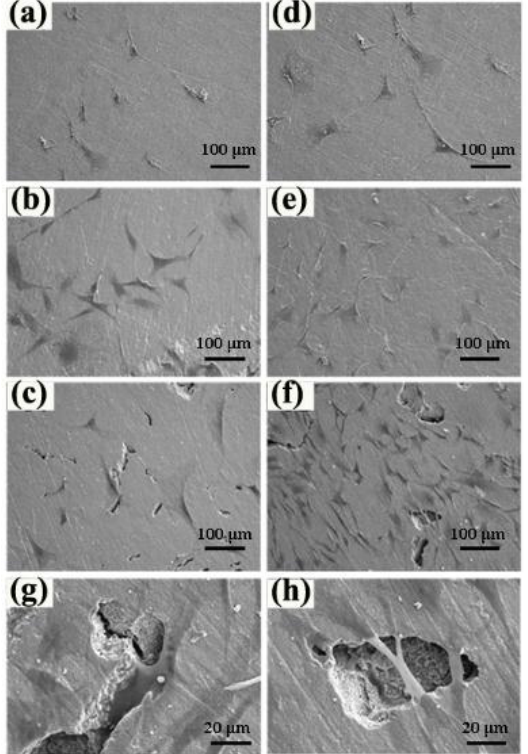
Figure 5. Morphologies of rBMSCs after one and five days culture. ( a – c ) the morphologies of rBMSCs after 1 day culture; ( d – f ) the morphologies of rBMSCs after five days culture; ( a , d ) 0 wt % stearic acid; ( b , e ) 5 wt % stearic acid; ( c , f ) 10 wt % stearic acid; ( g , h ) magnified images of picture.